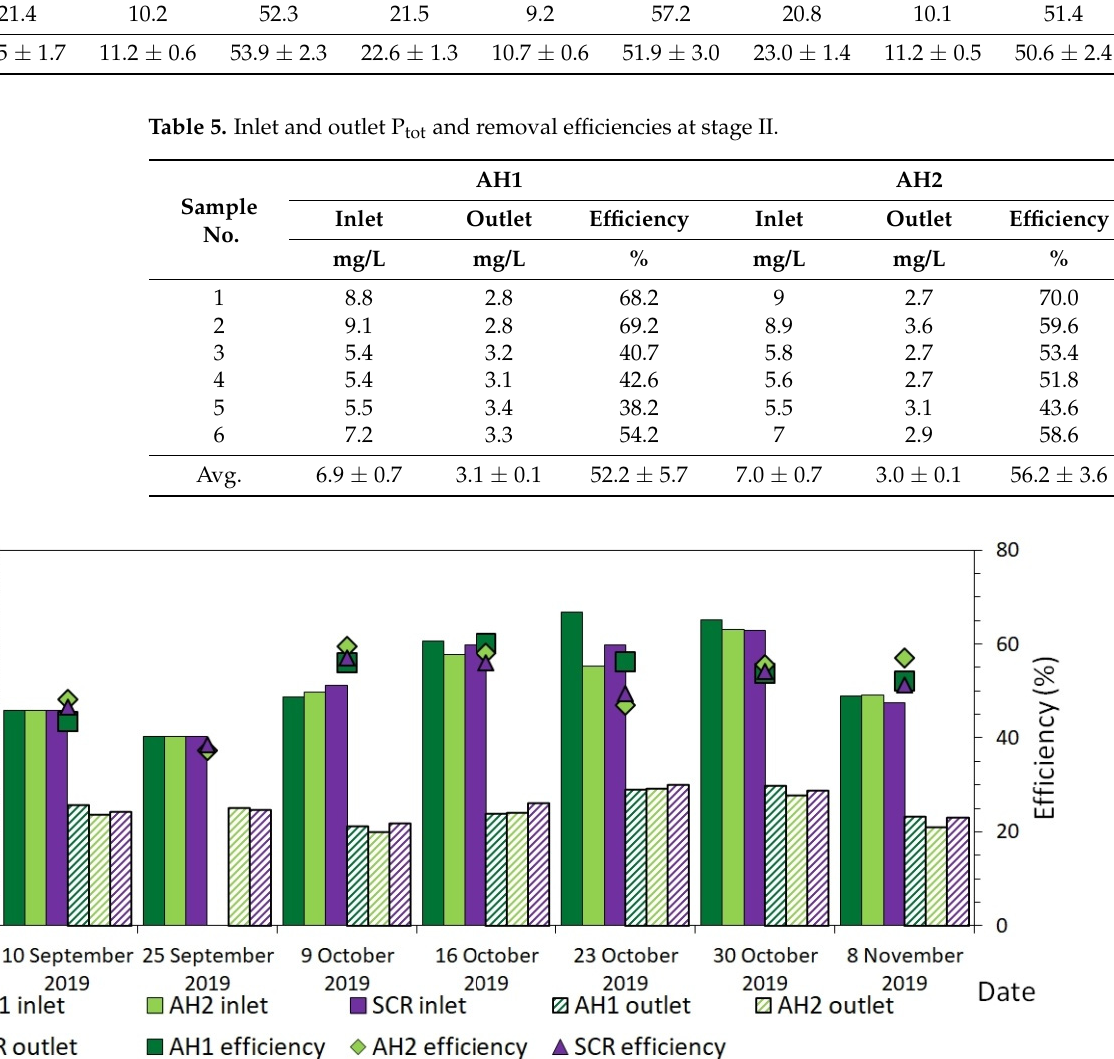
Figure 6. Inlet and outlet P tot and removal efficiencies at stage I.